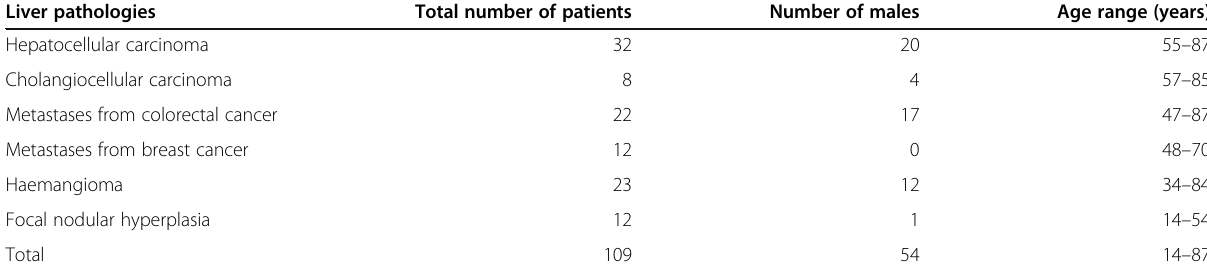
Table. 1 Group composition and demographic data of included subjects